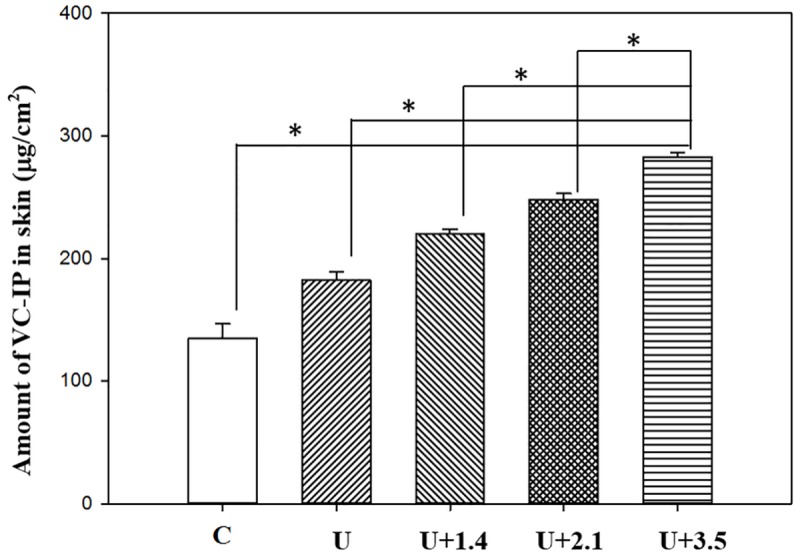
The amount of VC-IP deposited in the skin appeared to be higher in group U than in group C, and significantly so in groups U, U+1.4, U+2.1, and U+3.5.The amount of VC-IP that had permeated at 32 hours and the residual amount of the initially administered drug remaining in the skin. Data are mean and SD values.